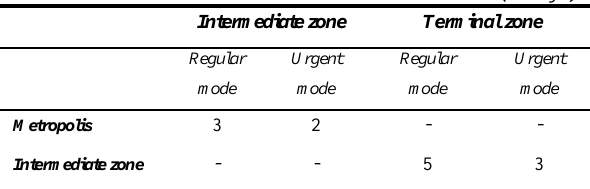
Fig. 5. Geographical arrangement of the CMSC